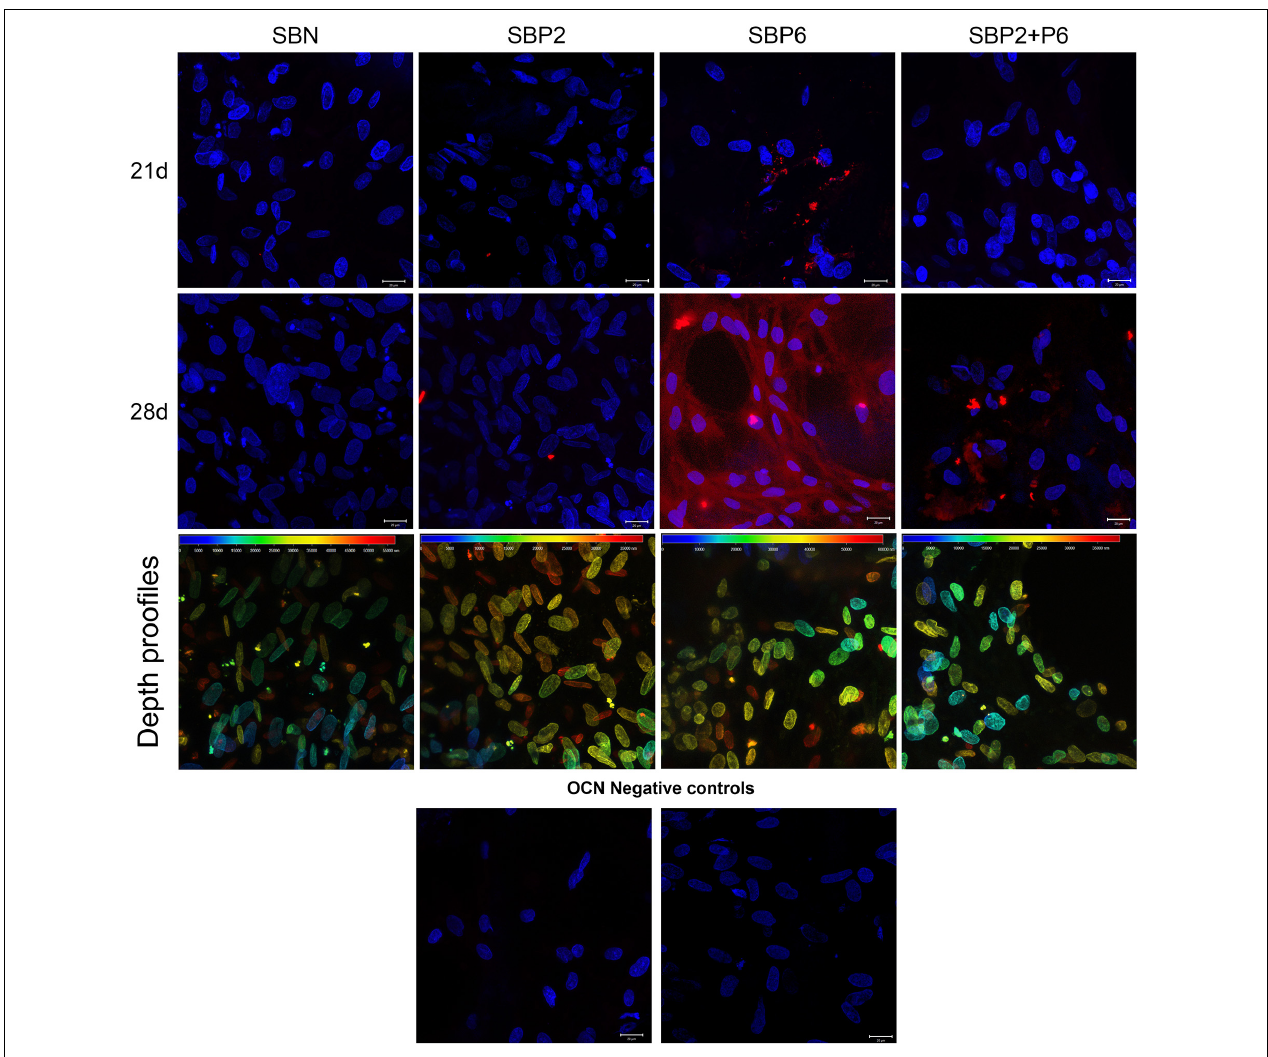
FIGURE 4 | Immunohistochemical staining of OCN (red) and Hoechst 34580 staining of cell nuclei (blue) on day 21 and 28. Cell penetration to the scaffolds are presented as depth profiles at day 28 in third row and OCN negative controls at the bottom. Scale bar: 20 µ m ( n =